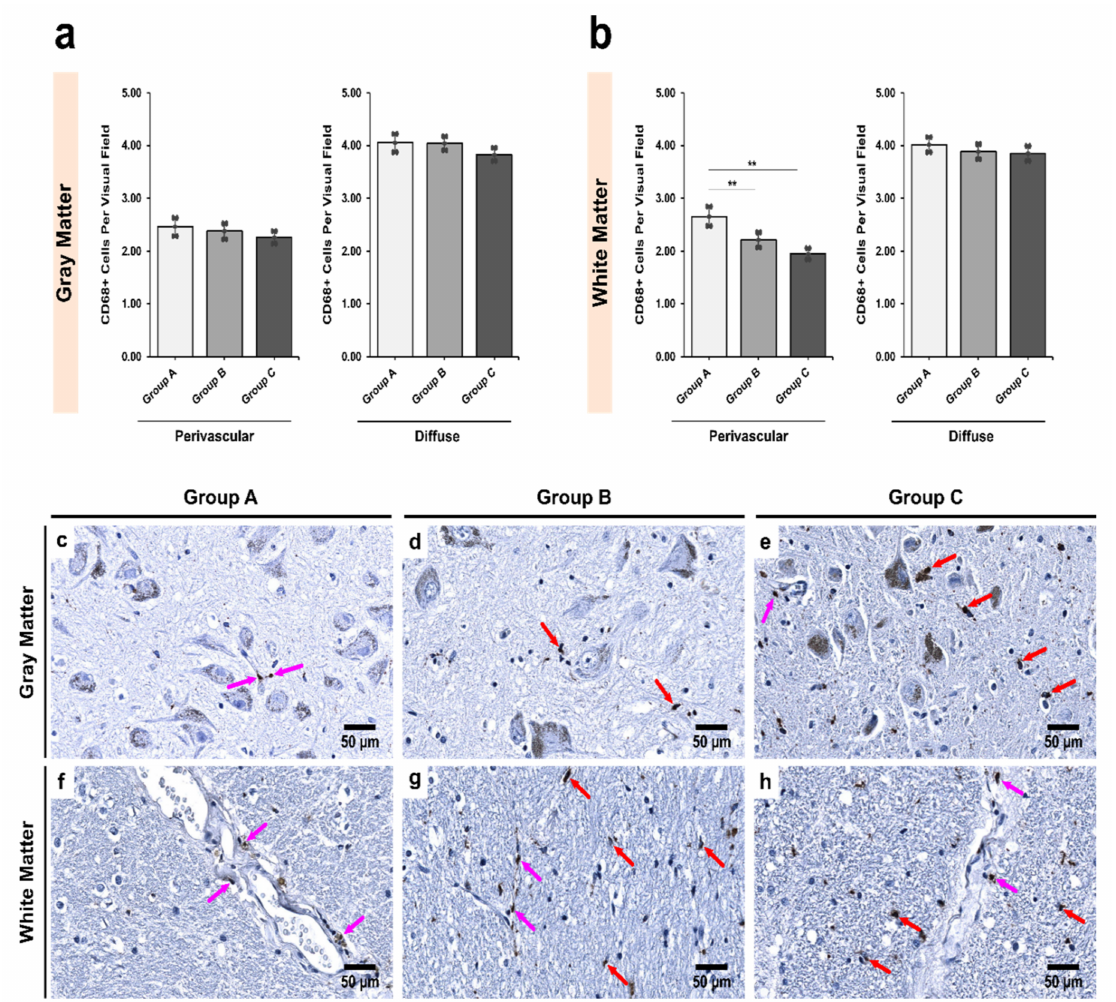
Figure 1. Intergroup analysis of CD68+ cells per visual field in Pars Compacta (SNpc) for the three studied groups in both ( a ) gray and ( b ) white matter. The analysis was done for both perivascular and diffuse locations. The bar plots indicate the average number of CD68+ cells ± S.E. (Standard Error) seen per visual field. ** indicates a significant difference between the groups ( p < 0.05 with Bonferroni correction is considered significant). Distribution of CD68+ cells per visual field in ( c , f ) Group A (controls); ( d , g ) Group B (age-matched alcoholics) and ( e , h ) Group C (non-age-matched alcoholics). Pink arrows indicate perivascular CD68+ cells while red arrows indicate diffuse CD68+ cells. Original magnification, 400 × . Scale bars, 50 µ